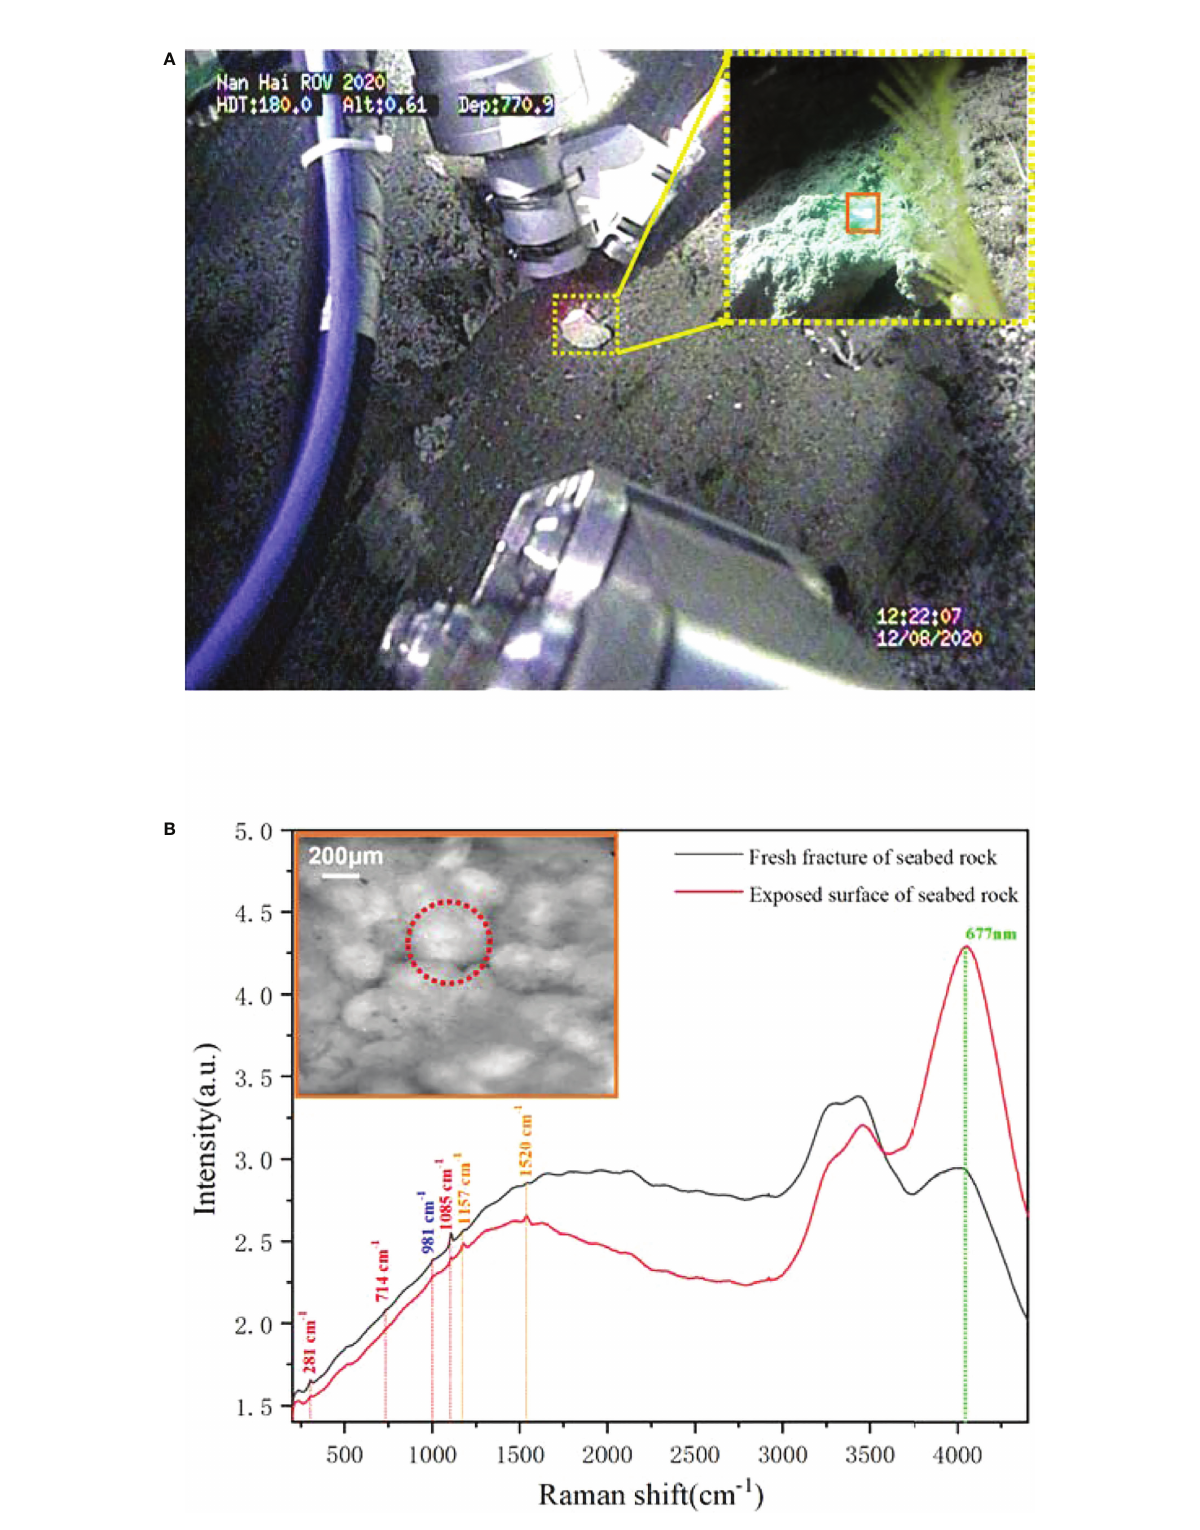
FIGURE 9 The in situ Raman detection and microimaging of the rock sample. (A) The scenario of underwater imaging and detection. (B) The Raman spectra obtained from the benthic rock